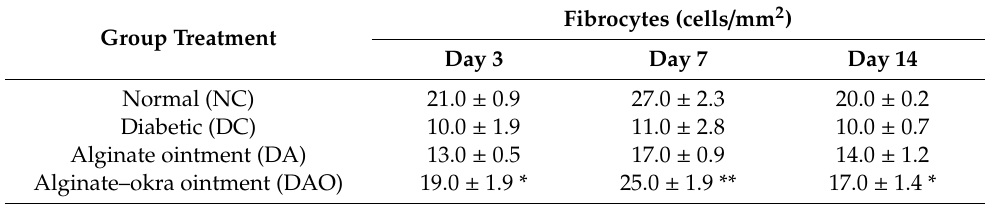
Table 6. Counts considering the mean and standard deviation of